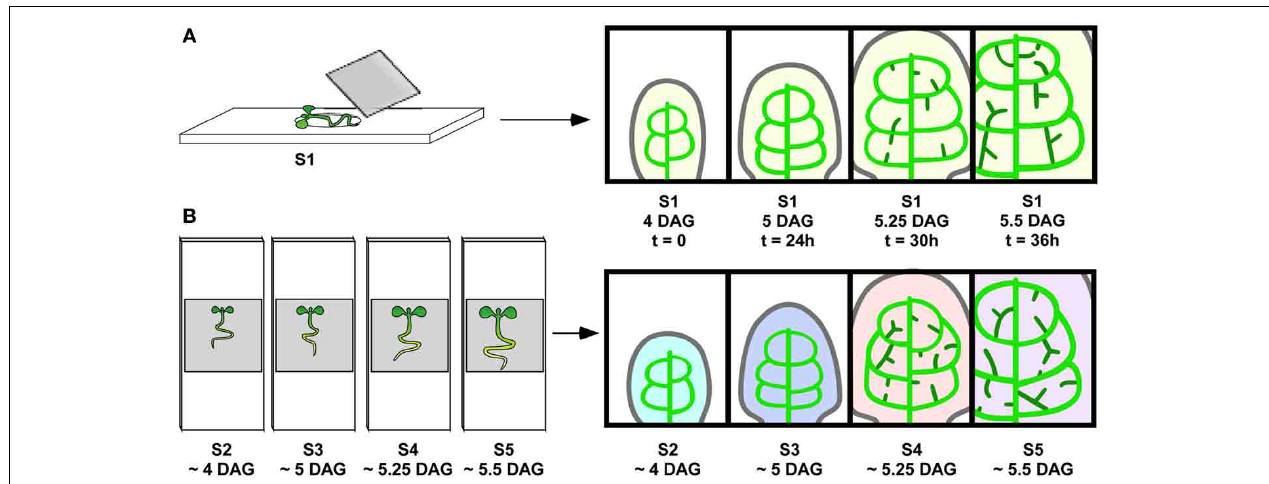
FIGURE 1 | Live imaging vs. reconstruction of vein ontogeny from staged samples. (A) Live imaging. Sample S1 (left) growing in growth medium on depression slide and put under cover slip for visualization at intervals tested for not interfering with vein development to produce a series of images (right). Since the same veins are visualized repeatedly over time, one can follow the development of the randomly positioned hPEDs. (B)